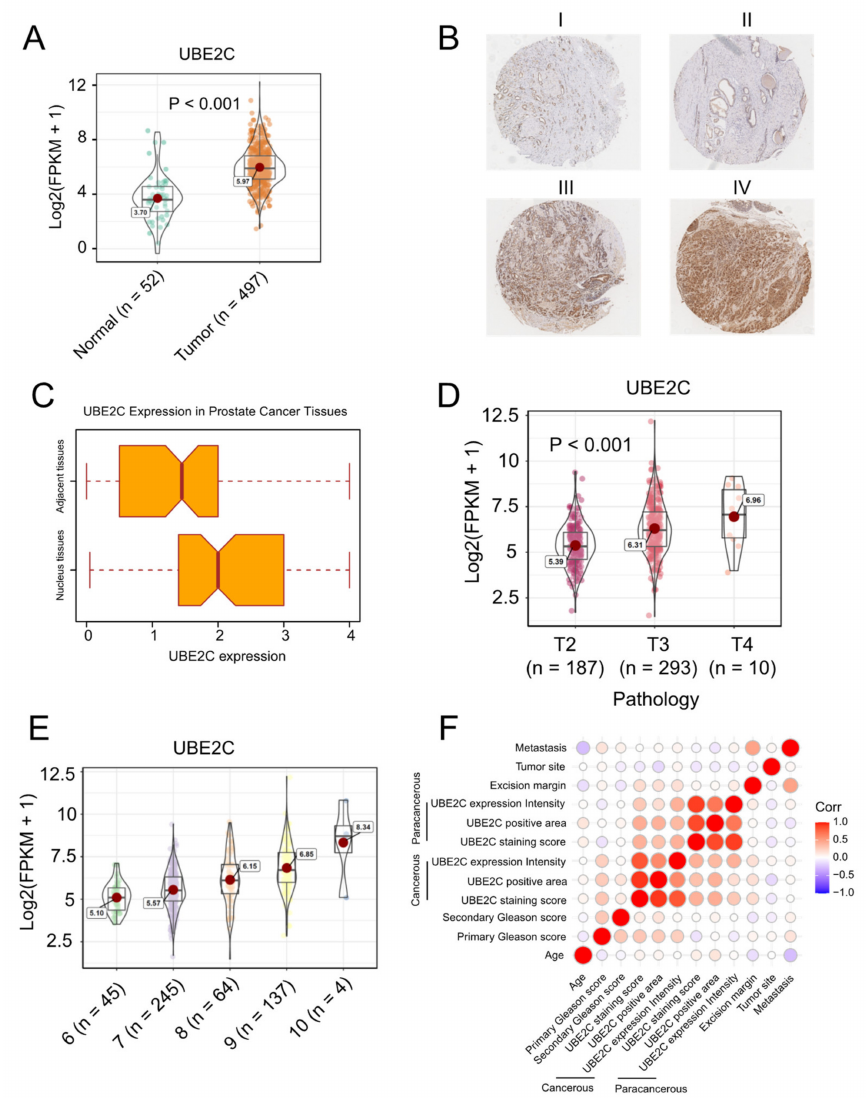
Figure 2. UBE2C is strongly associated with a malignant level of PCa in both TCGA and our cohort. ( A ) The expression of UBE2C in PCa was significantly higher than that in normal prostate tissue. ( B ) The represented pictures of UBE2C protein expression in the prostatic tissues (magnification scale 100 × ) I. IHC score 4 = 100% × 4 II. IHC score 4 = 100% × 4 III. IHC score 0.1 = 10% × 1 IV. IHC score 0.7 = 70% × 1. ( C ) The immunohistochemical characteristics of UBE2C expression in PCa tissues and the adjacent tissues (paired Wilcoxon test, p -value = 0.0002446). ( D ) In the TCGA